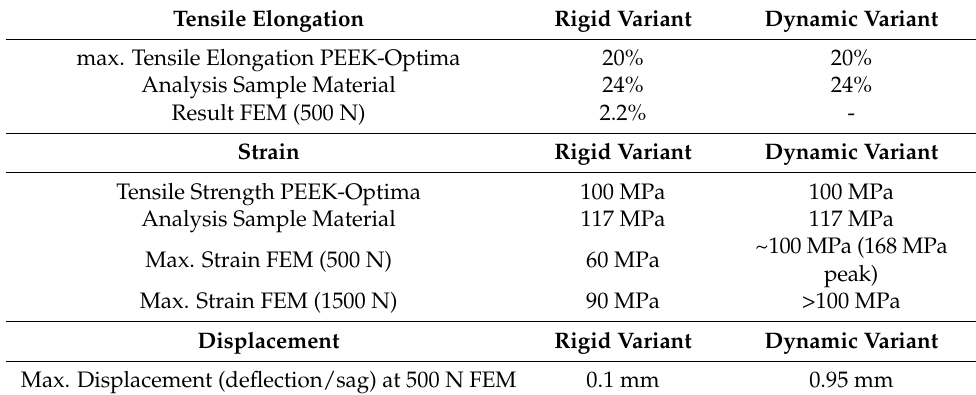
Table 3. Summary of FEM simulation results.